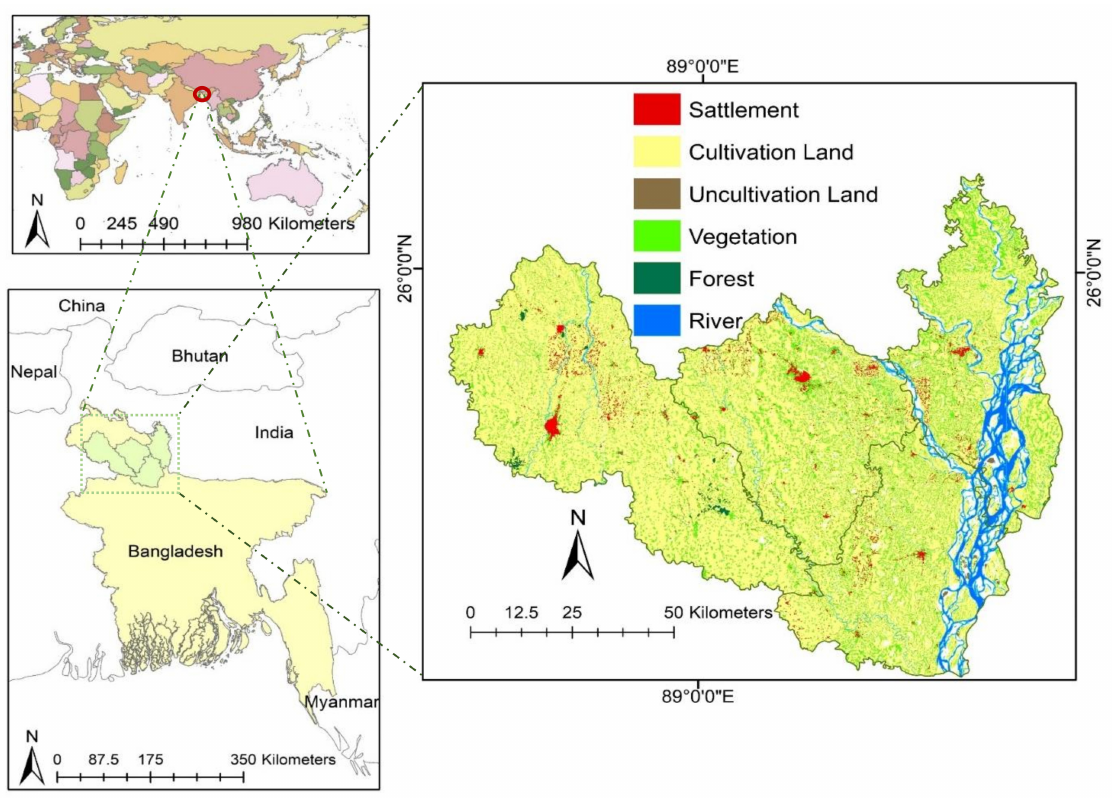
Figure 2. Study area: northern part of Bangladesh, four districts: Dinajpur, Rangpur, Gaibandha, and